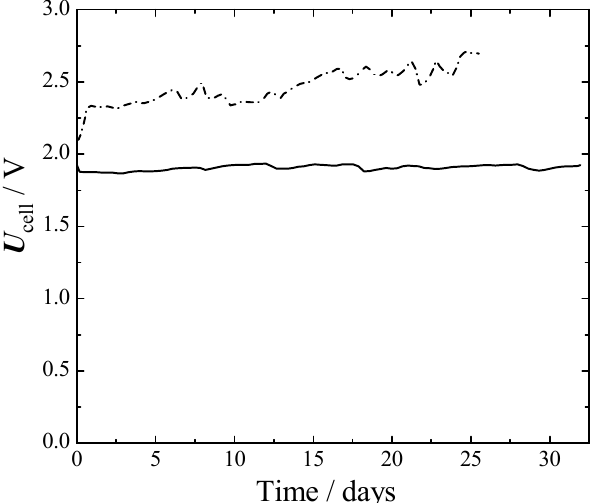
Figure 6. Cell voltage of long-term one-month experiments at a fixed current density and temperature. 75 °C, 1 atm. 300 mA cm –2 . Full line—cathode: Ra-Ni, anode: SS316L. Dash dot line—cathode: aged bare-Ni, anode: aged bare-Ni.